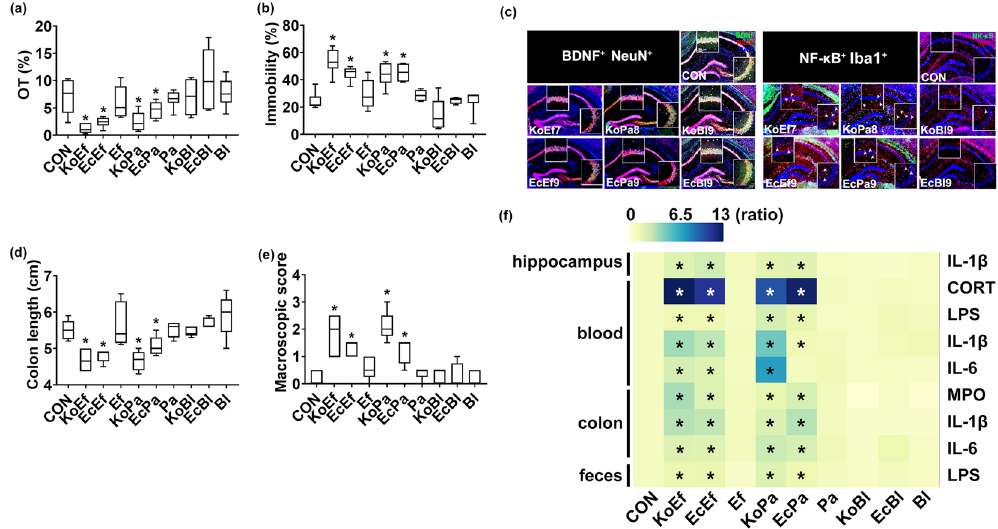
Figure 5. Combined effects of Enterococcus faecium (Ef) , Pediococcus acidilactici (Pa), or Bifidobacterium longum (Bl) with Enterobacteriaceae on the occurrence of anxiety/depression and colitis in mice. Effects on the occurrence of anxiety/depression in the EPMT ( a ) and TST ( b ). Effects on the BDNF + /NeuN + and NF-κB + / Iba1 + cell population in the hippocampus ( c ). Effects on the colon length ( d ) and macroscopic score ( e ). ( f ) Effects on the IL-1β, IL-6, LPS, MPO, and corticosterone levels, indicated as compared to control group (CON: 1). Heatmap was generated using Plotly (https:// chart- studio. plotly. com). Each two bacteria (KoEf, 1:1 of Ko and Ef; KoPa, 1:1 of Ko and Pa; KoBl, 1:1 of Ko and Bl; EcEf, 1:1 of Ec and Ef; EcPa, 1:1 of Ec and Pa; EcBl, 1:1 of Ec and Bl) combination at a dose of 1 × 10 7 (KoEf), 1 × 10 8 (KoPa), or 1 × 10 9 CFU/mouse/day (EcEf, EcPa, EcBl, Ef, Pa, and Bl) was orally gavaged once a day for 5 days in mice. Control mice were treated with vehicle (saline) instead of gut bacterial suspension. Data are shown as box plots (n = 8). *p < 0.05 vs Con. All were analyzed using unpaired t